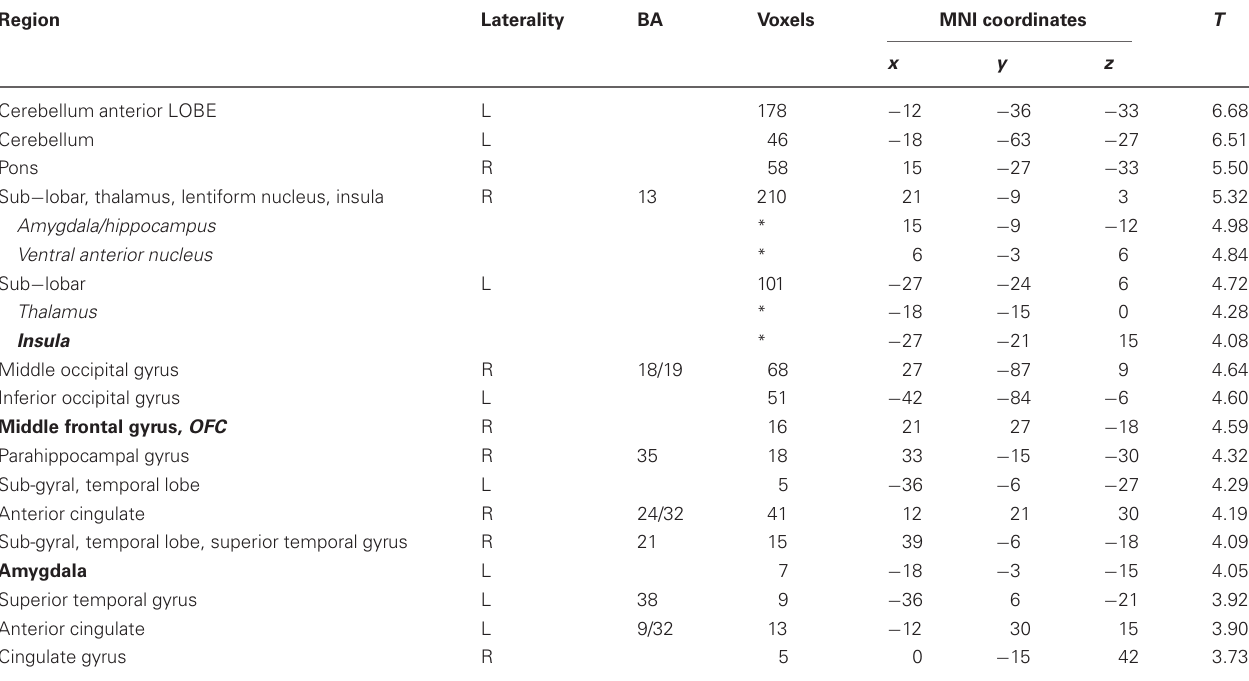
Table 2 | Areas showing deactivations in the difference of the parametric regressors (Real × Bid − Hypothetical × Bid). Region Laterality BA Voxels MNI coordinates